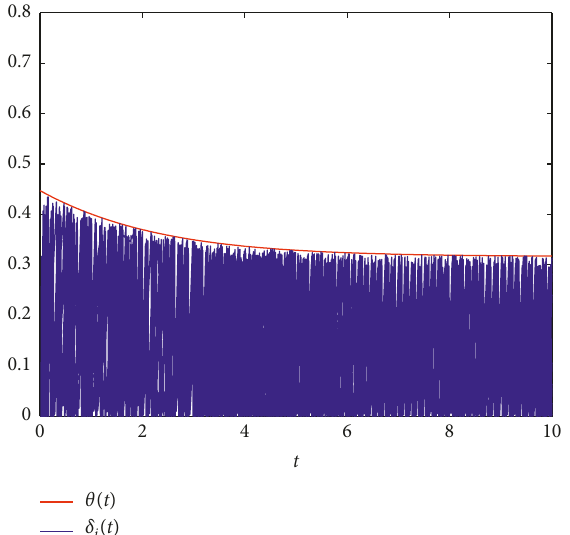
Figure 8: Evolution of measurement error and threshold with θ 0 . 5 under continuous feedback, i � 1 , 2 , ... , 10.